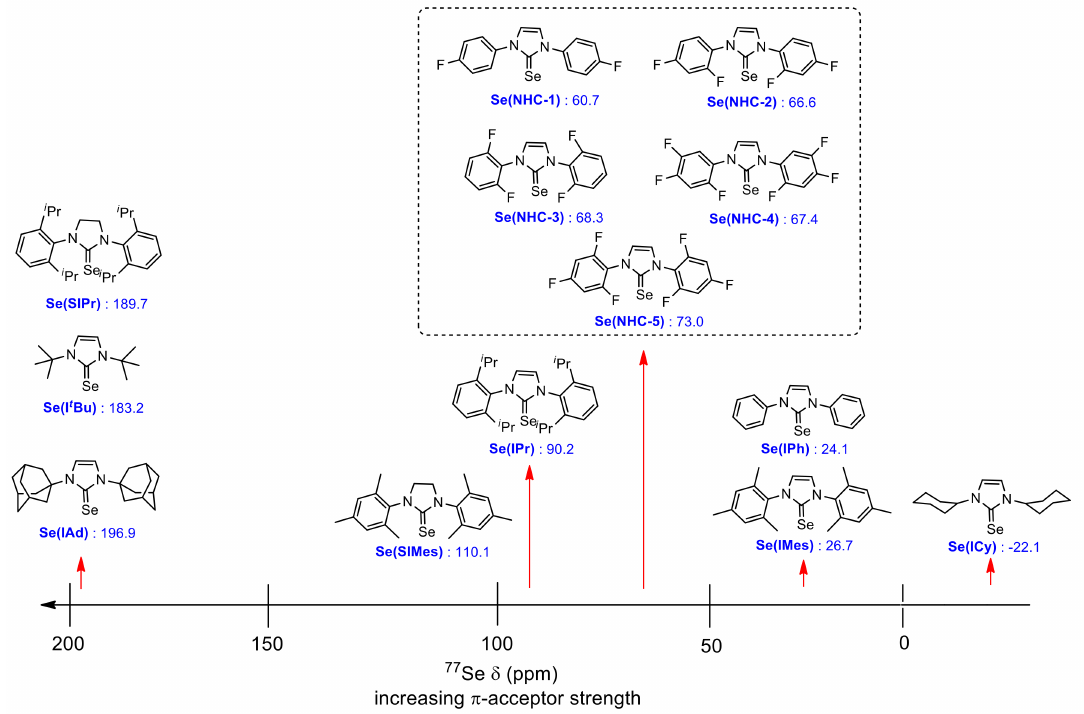
Figure 5. The 77 Se NMR chemical shifts for various selenium-NHC